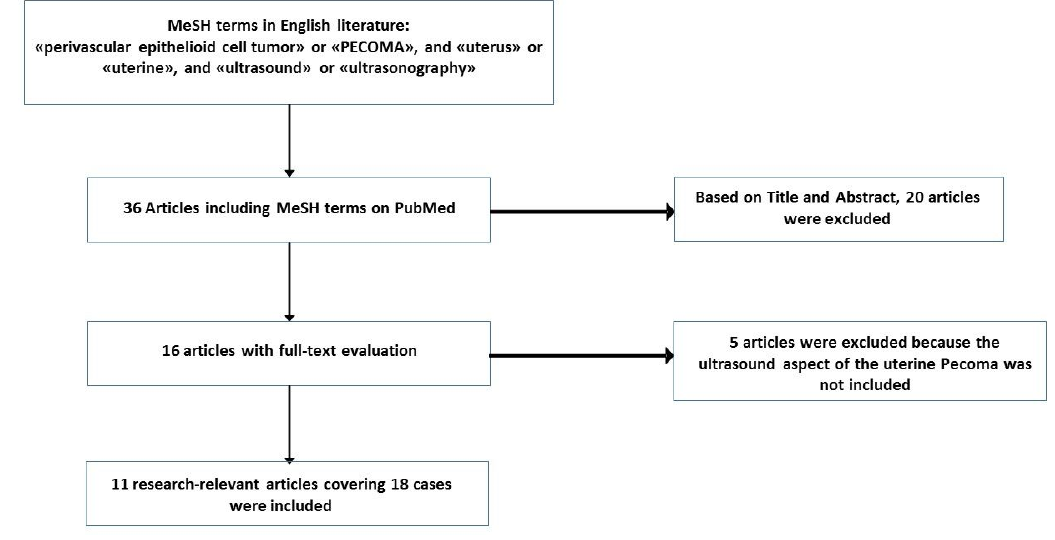
Figure 4. Search strategy flowchart.